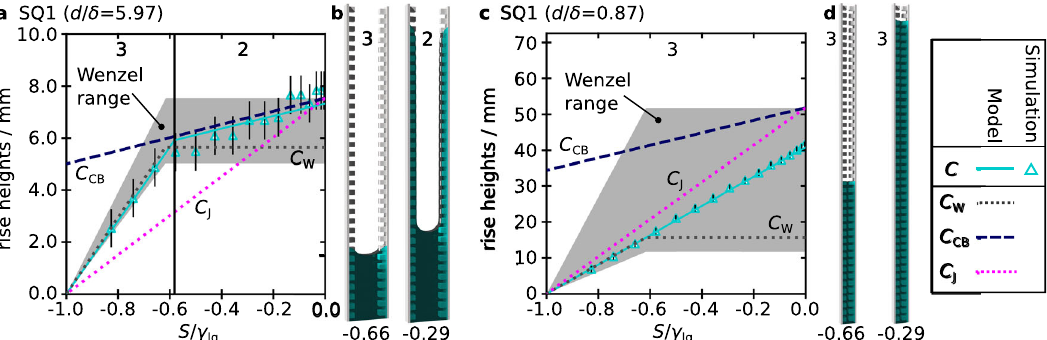
Fig. 3 Capillary rise against gravity between two rough plates of variable wetting parameter, S . a Comparison of the capillary rise heights between the: Dual-Rise Model, C , Jurin ’ s Law, C J , and the apparent angle approximations, C W (Wenzel approximation) and C CB (Cassie-Baxter approximation), for the simulated square-pillared system SQ1 at a moderate value of the plate separation to roughness depth ratio ( d / δ = 5.97). The rising liquid is water ( λ c = 2.7 mm), and we vary the substrate wettability S (normalised with respect to the liquid-gas interfacial tension γ lg ). The shaded region indicates the range of possible Wenzel capillary rise predictions when varying the plate separation, x , in Eq. (13). Error bars in the simulated data indicate the ± 1 post uncertainty. b Example equilibria at d / δ = 5.97 in region 3, S / γ lg = − 0.66 ( θ = 70°), and region 2, S / γ lg = − 0.29 ( θ = 45°). c Model comparison with the simulated system SQ1 at narrow plate separation ( d / δ = 0.87). d Example equilibria at d / δ = 0.87 in region 3 at S / γ lg = − 0.66 ( θ = 70°), and S / γ lg = − 0.29 ( θ =